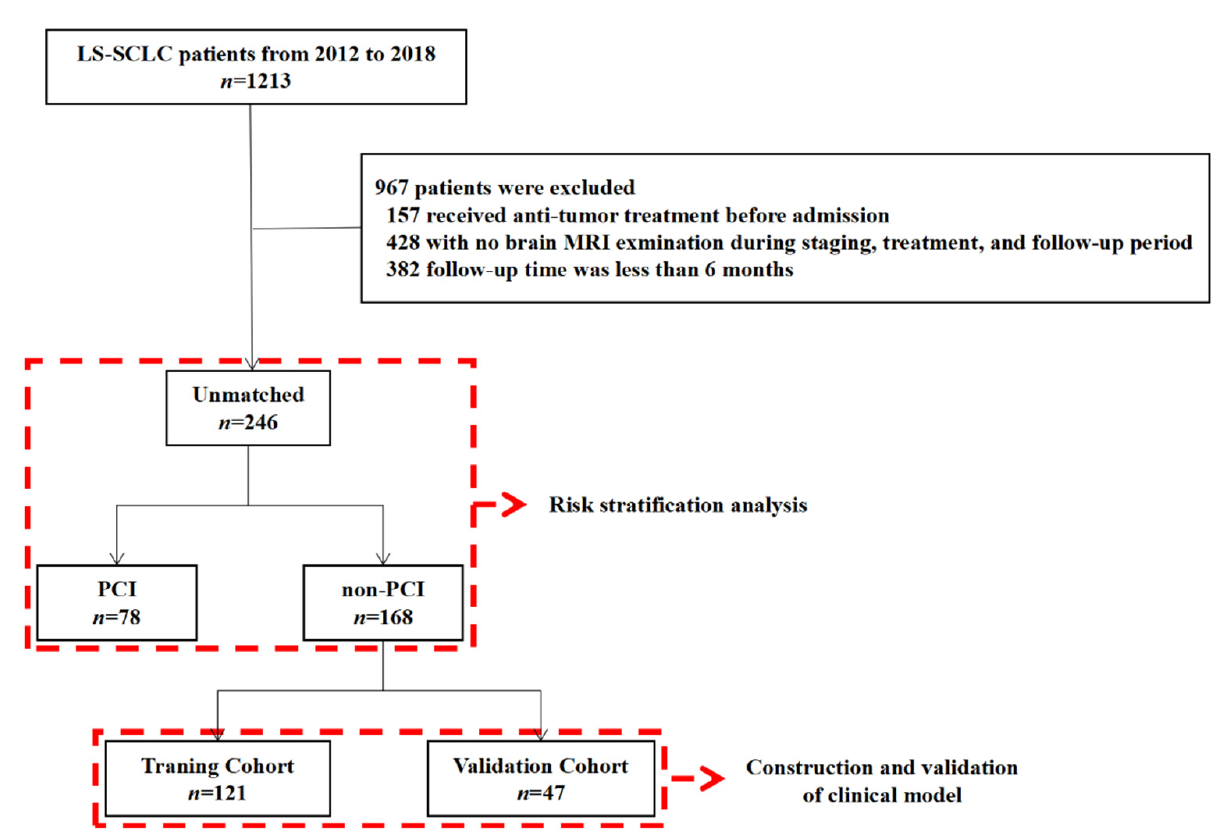
Figure 1. Diagram of patient enrollment and subgroup analysis. A total of 1213 patients with LS-SCLC met the inclusion criteria. Finally, only 246 patients were eligible to enroll in this study.